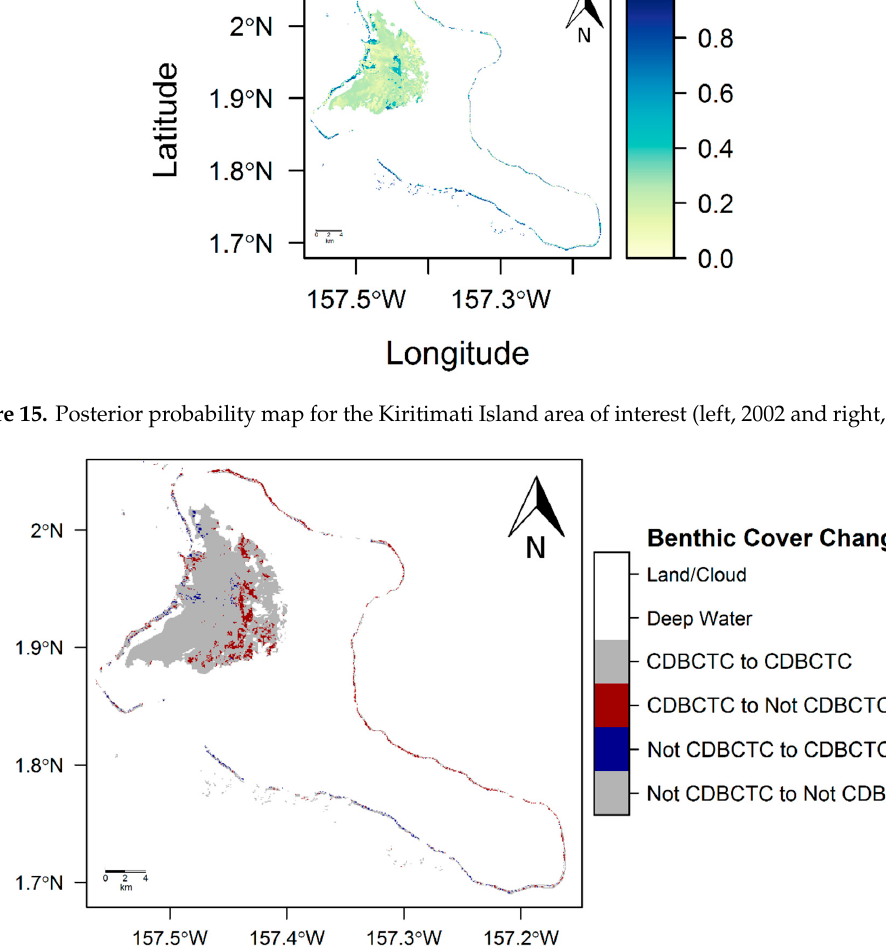
Table 7. Classification accuracy of select additional learning algorithms.